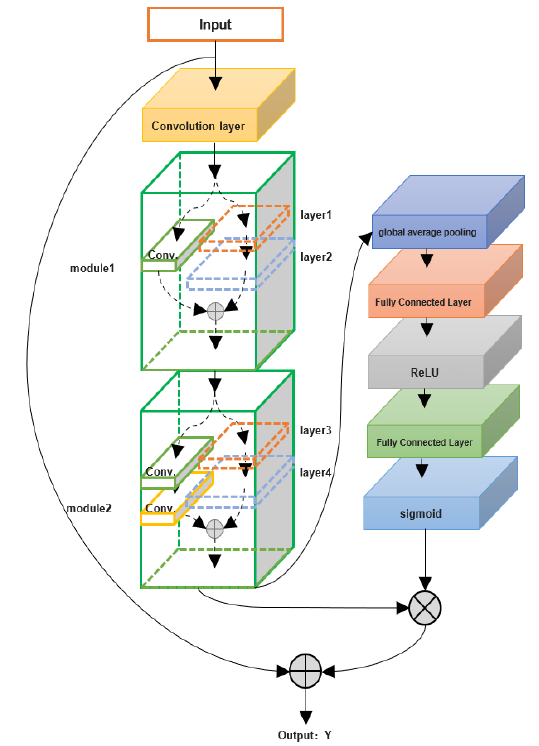
Figure 6. Block structure of RFSE-ResNeXt.